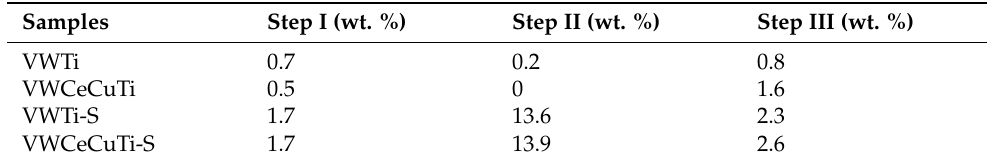
Table 2. Weight losses of catalysts during the TGA processes.